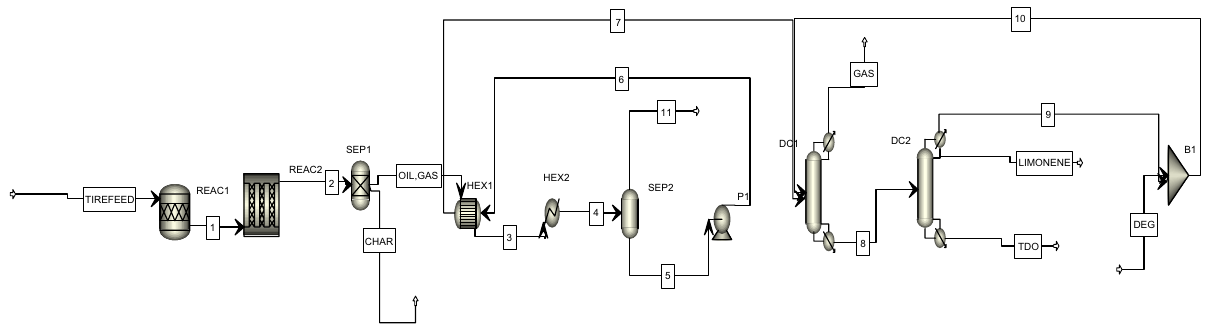
Figure 1. The developed simulation in software